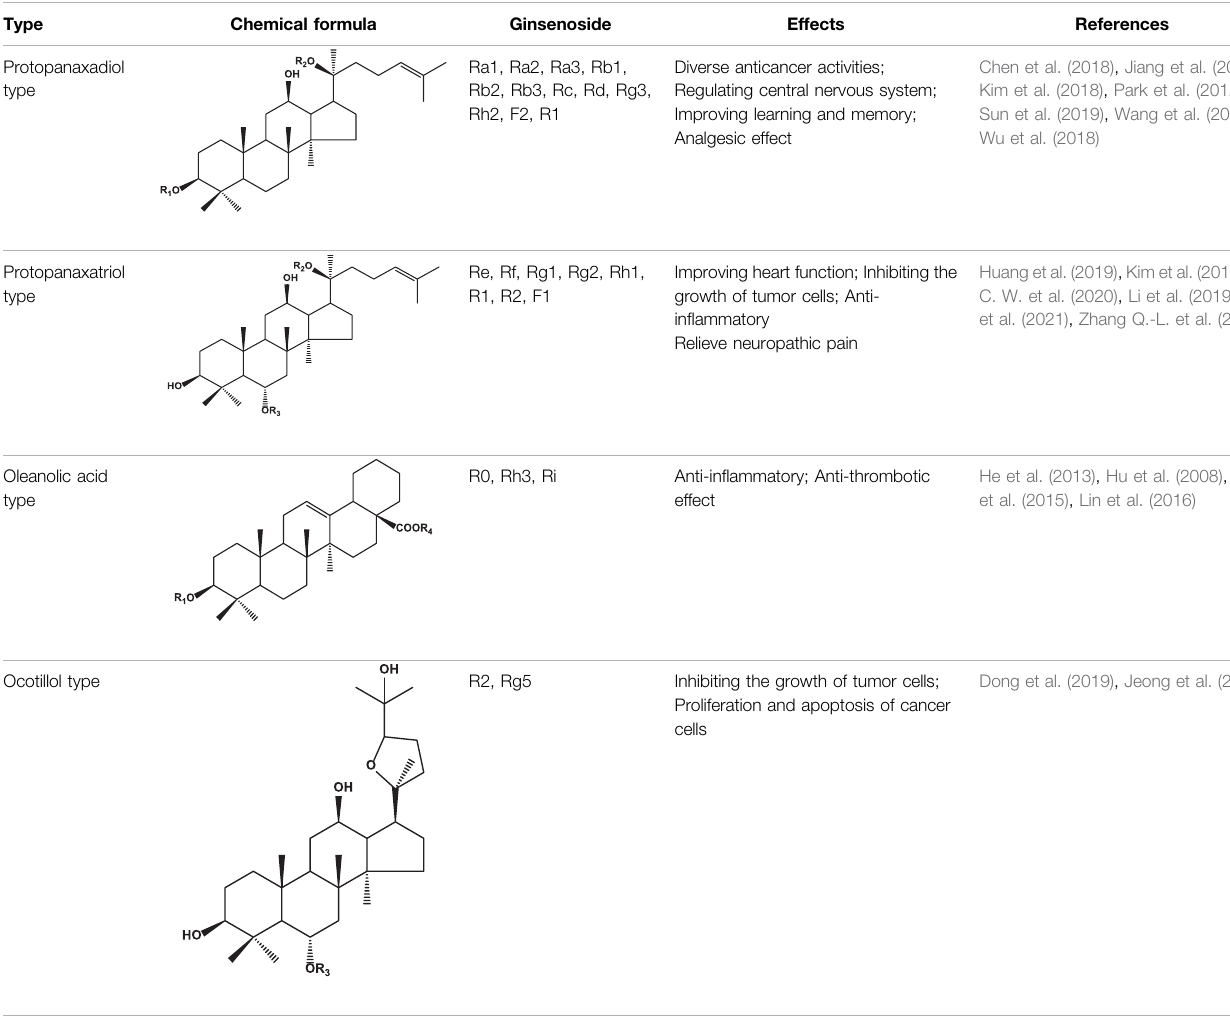
TABLE 1 | Classi fi cation of ginsenosides and their